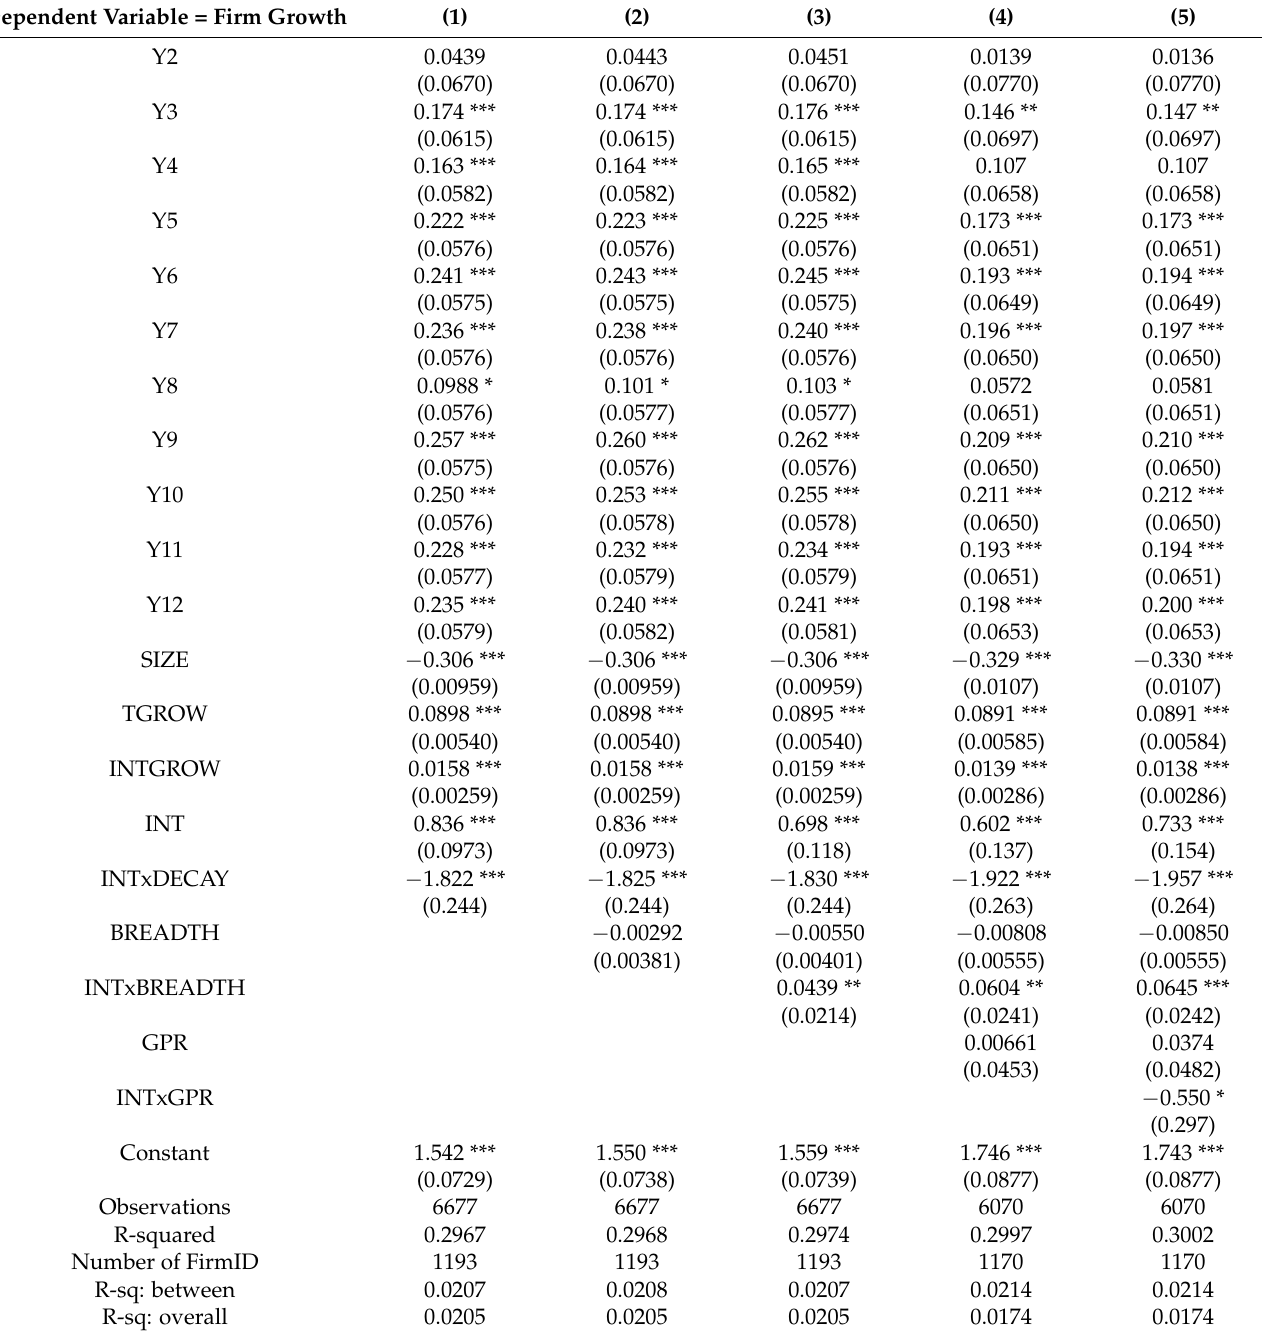
Table 8. Effect of breadth and GPR on firm growth, under the effect of intangibles decay. Dependent Variable = Firm